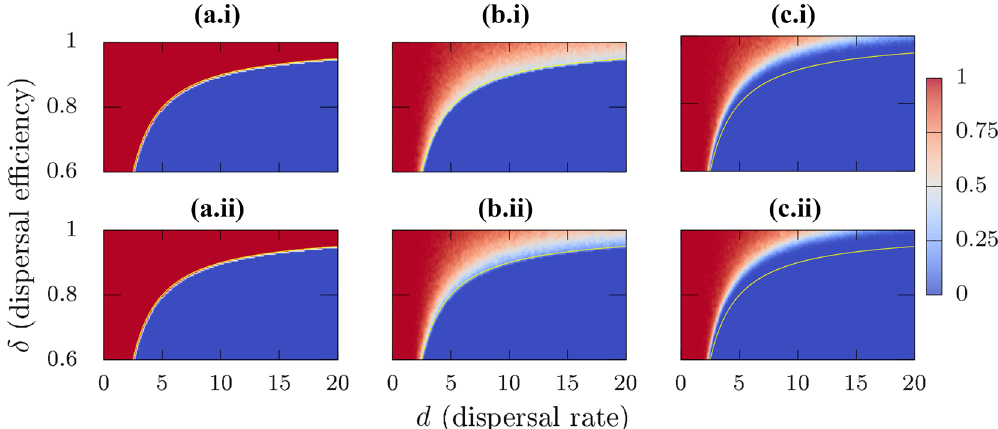
Figure 6. (i) P per projection on the ( d , δ) plane for homogeneous patches, and (ii) for the heterogeneous patch case. [( a.i ),( a.ii )] correspond to all-to-all connected system, [( b.i ),( b.ii )] to fixed NBM, and [( c.i ),( c.ii )] to rewiring NBM with a rewire every 100 time units. The blue shaded area corresponds to meta-population 0 , whereas red regimes correspond to P per 1 . The boundary between persistence and extinction, i.e. P per = = extinction for the all-to-all connected system is indicated by a yellow curve which for comparison, is indicated 100 for these calculations. Corresponding biomass calculations are shown in Online in all panels. N ensemble = Appendix Fig.